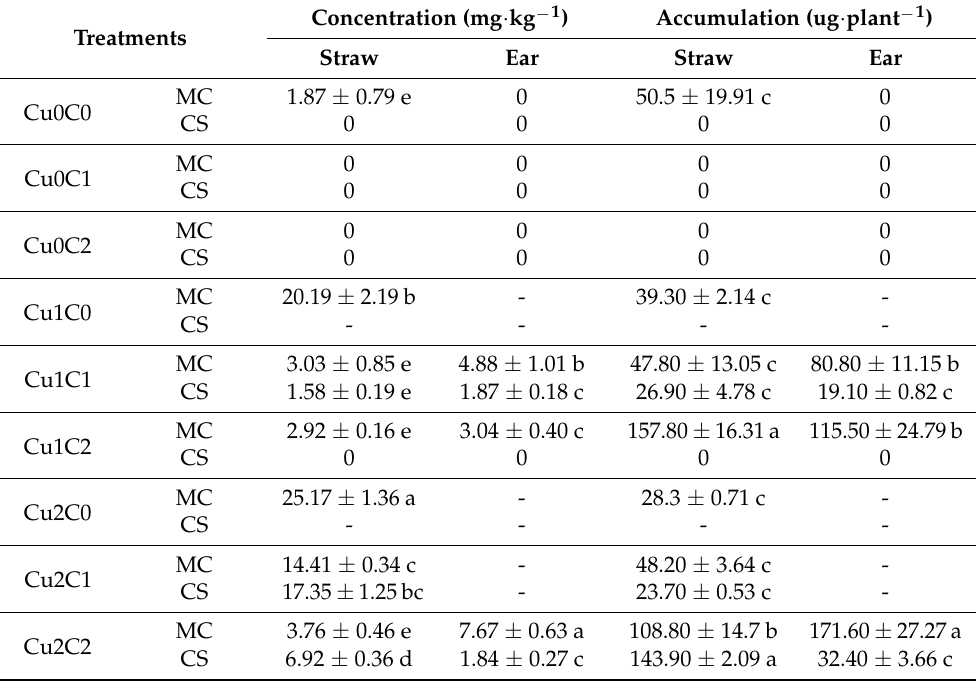
Table 1. Cu content and accumulation of sweet corn.